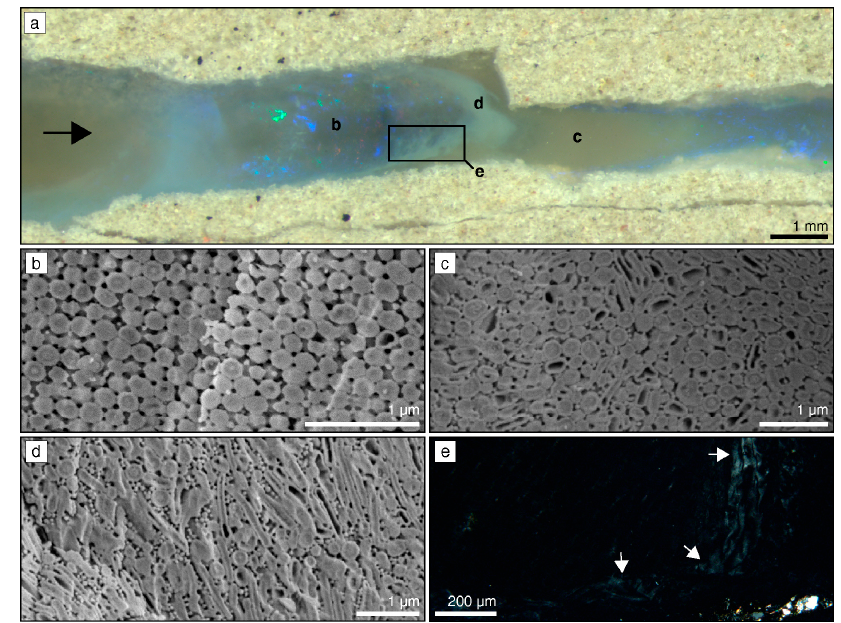
Figure 4. Textures and microstructural features of Andamooka vein opal. The SE images ( b , d ) were obtained after hydrofluoric acid (HF) etching. ( a ) Photograph of alternating zones of transparent precious and translucent to milky common opal. The parabolic interfaces point toward the fracture tip (arrow). ( b ) SE image of precious opal composed of ordered uniform spheres. ( c ) SE image of irregularly arranged spheres and minor nonspherical particles in translucent common opal. ( d ) White to milky common opal composed of ellipsoidal particles with a preferred orientation ~N–S and a maximum aspect ratio of 0.25. ( e ) Microphotograph (crossed polarizers) of the area highlighted in ( a ) depicting the faint grey birefringence of ellipsoidal, ordered particles in white to milky common